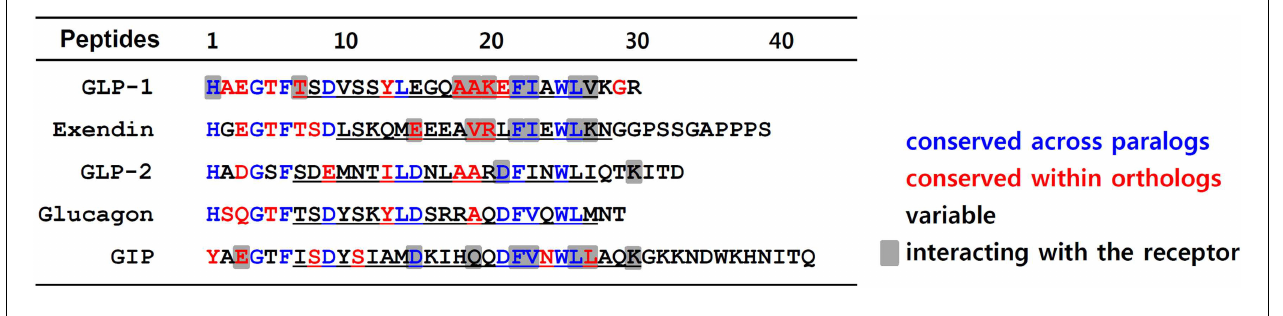
stickleback, and zebrafish.The residues colored in blue represent conserved sequences across paralogs.The residues in black are variable sequences. Underlines indicate the α -helical conformation. The residues responsible for interaction with their receptor are